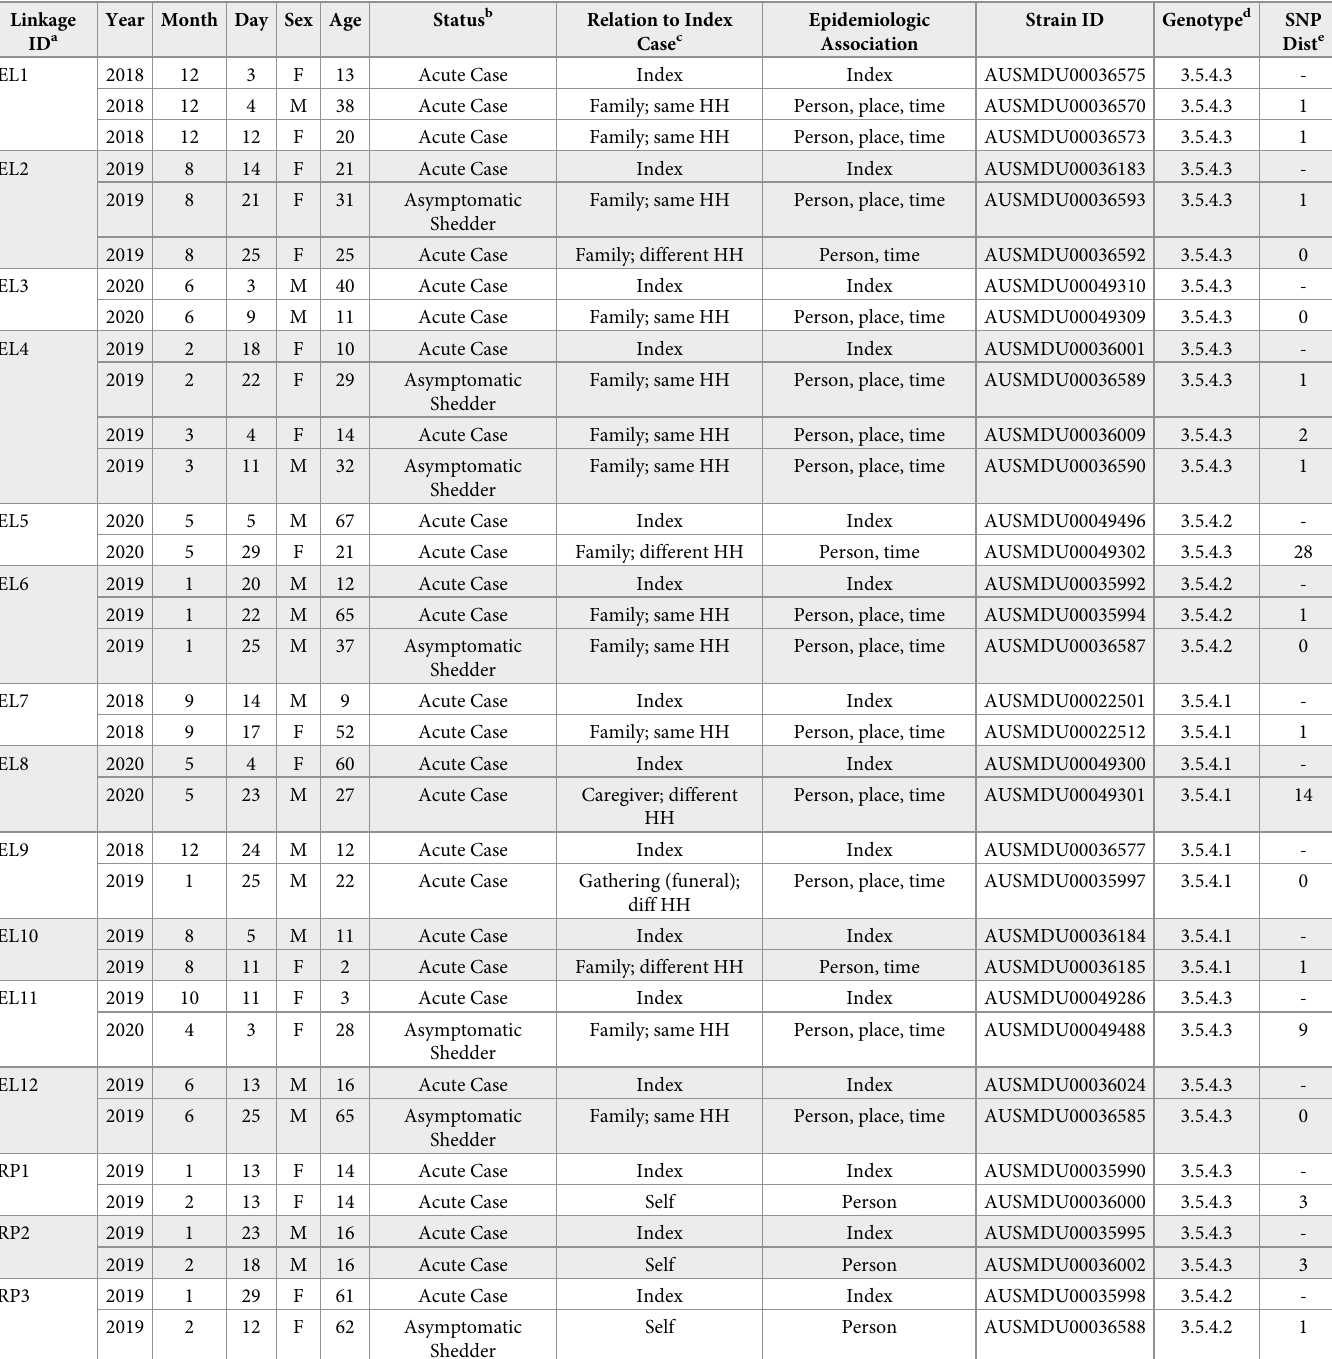
Table 4. Suspected epidemiologic linkages detected through active surveillance and associated genotype and pairwise SNP distance between isolates. Linkage ID